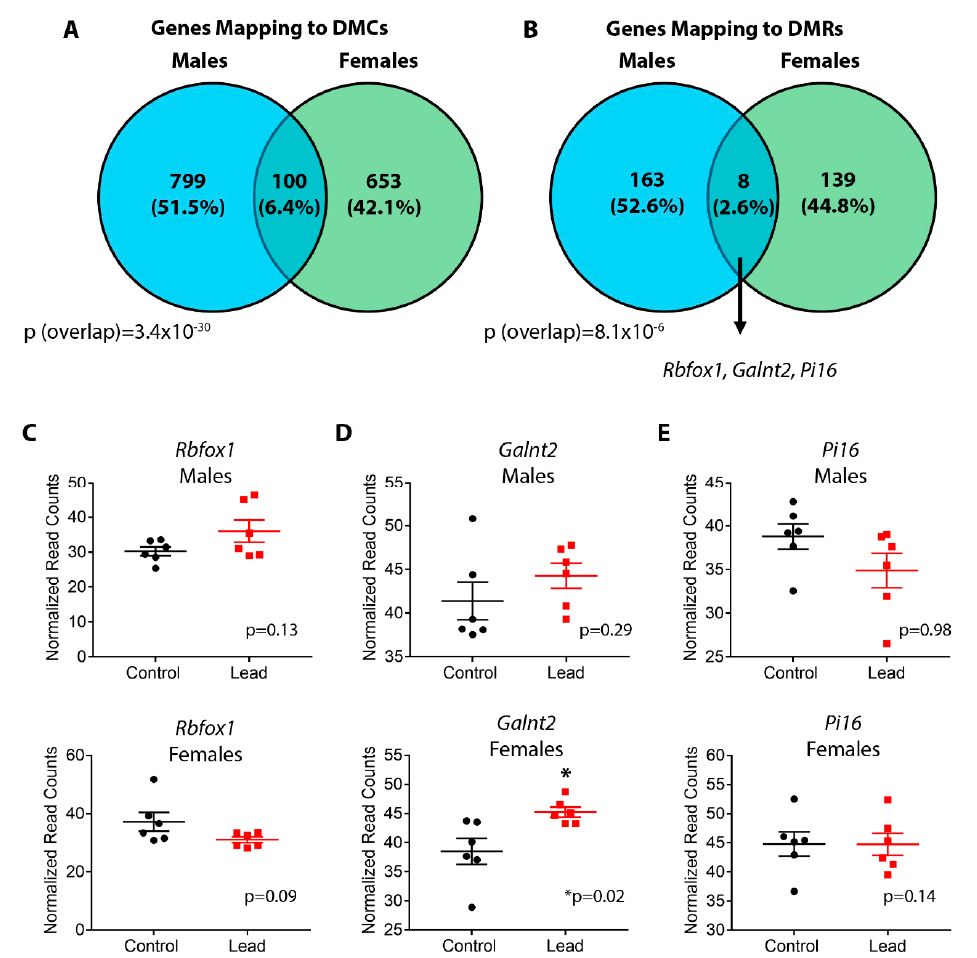
Figure 7. Venn Diagrams showing overlap in differentially methylated cytosine (DMC) ( A ) and differentially methylated regions (DMR) ( B )-associated genes between males and females. Statistical significance of overlap was determined using a hypergeometric test. In panel B, three DMR-associated genes (Rbfox1, Galnt2, Pi16) that overlap between males and females are highlighted due to their association with cardiovascular disease. Panels ( C–E ) depict normalized RNA-seq read count data for these three genes in males (top panel) and females (bottom panel) at 5 months of age. Black circles and red squares represent control and Pb-treated animals, respectively. Statistical significance was determined using linear mixed-effects regression, with litter-specific random effects to account for within-litter